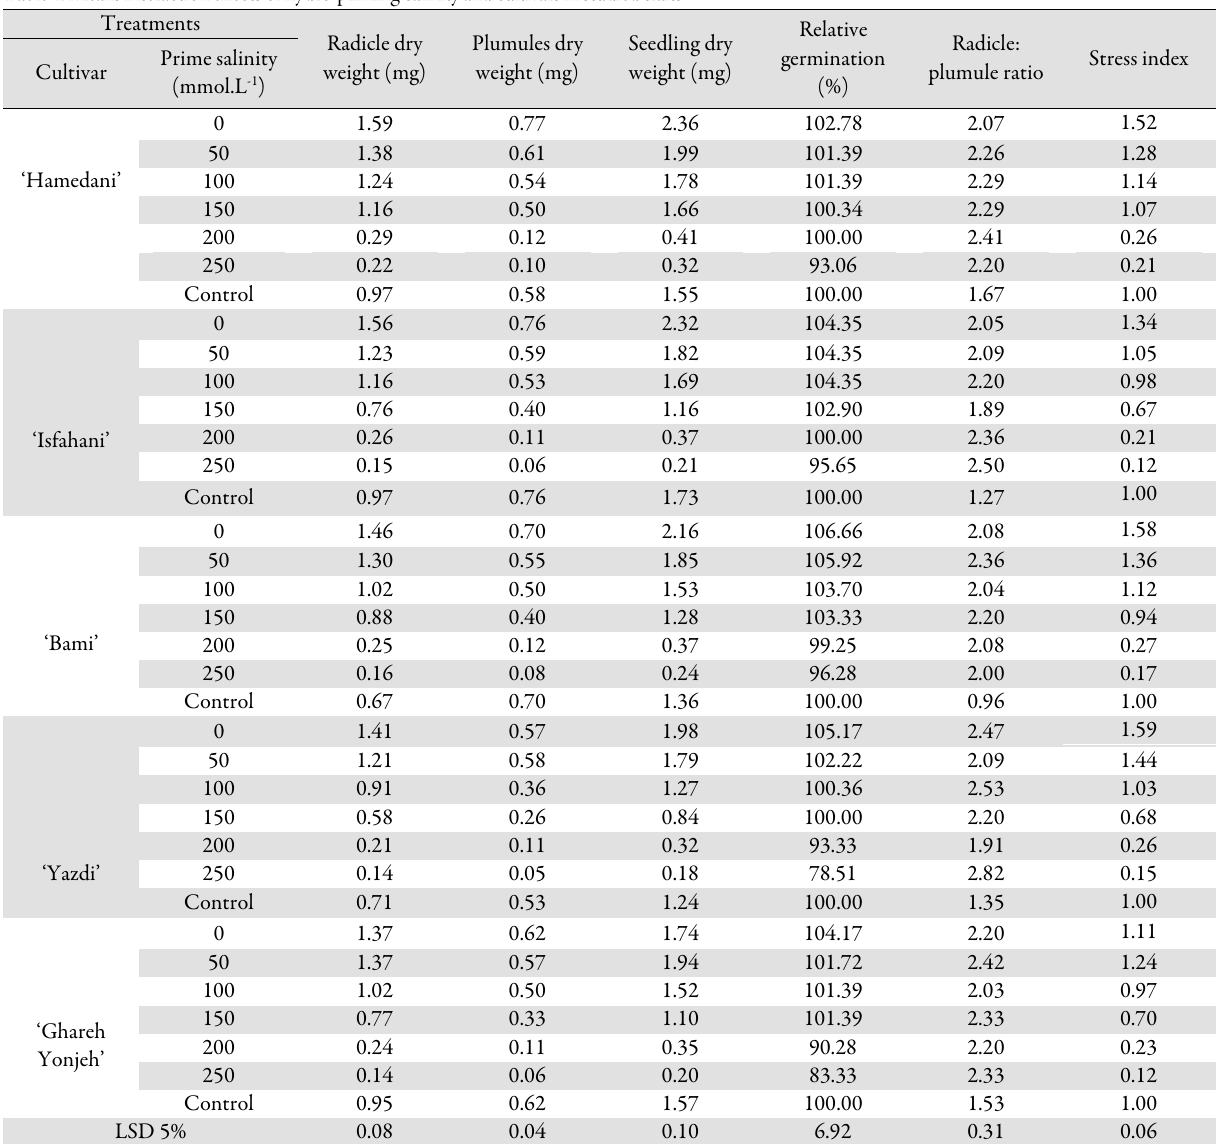
Table 4. Means interaction effects of hydro-priming-salinity and cultivars in studied traits